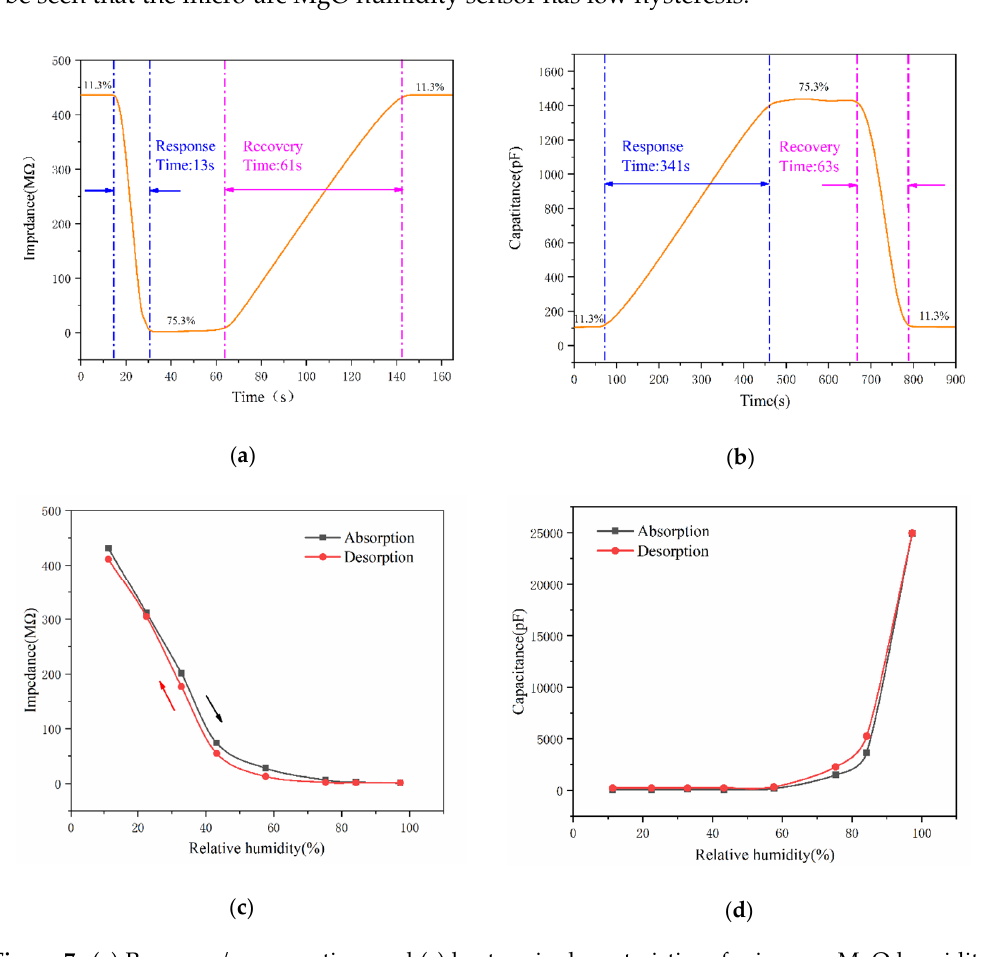
Figure 7. ( a ) Response/recovery time and ( c ) hysteresis characteristics of micro-arc MgO humidity sensor with impedance as response signal; ( b ) response/recovery time and ( d ) hysteresis characteristics of the micro-arc MgO humidity sensor with capacitance as a response signal.